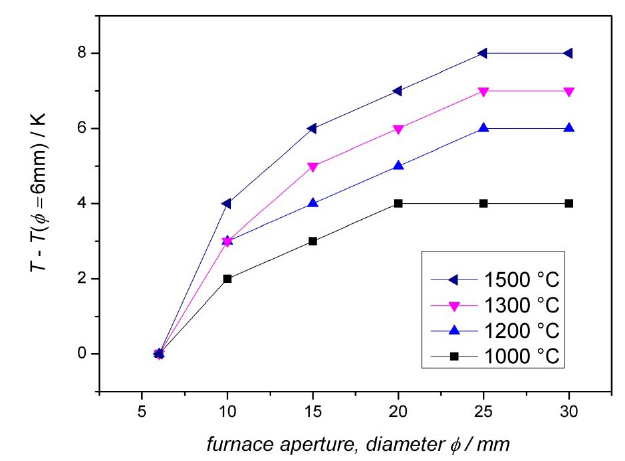
Figure 4. Influence of the size-of-source effect (SSE) on the temperature characteristics of a thermal imaging system based on a CCD camera.